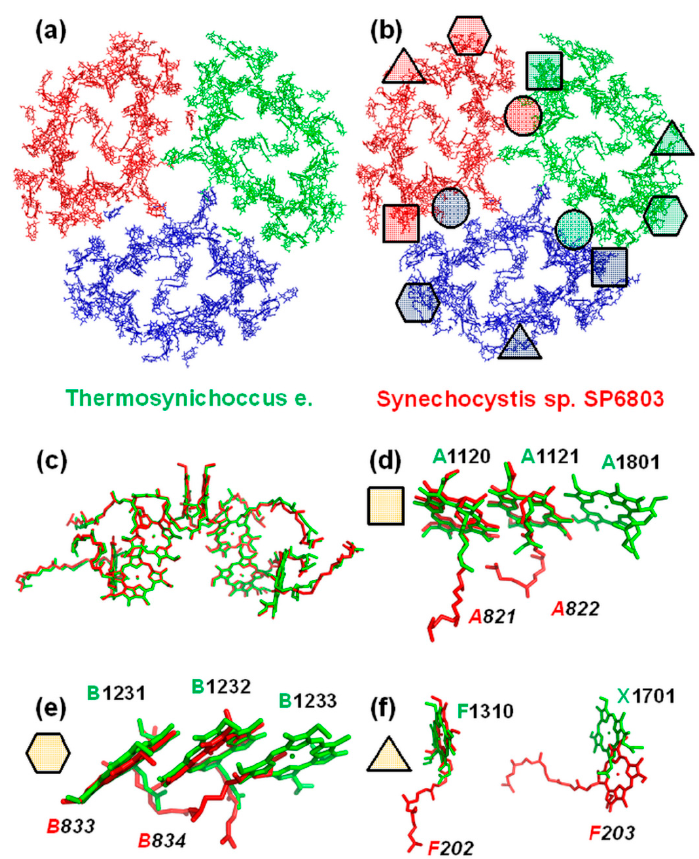
Figure 2. Differences of Chl arrangement in the PSI trimers isolated from Thermosynechococcus e. ( a ) and Synechocystis sp. SP6803 ( b ). The data were taken from the published crystal structures: 1JB0.pdb and 5OY0.pdb. The locations of RC cofactors are almost identical ( c ). The missing Chls in the Synechocystis structure are marked with geometric figures ( d – f ).